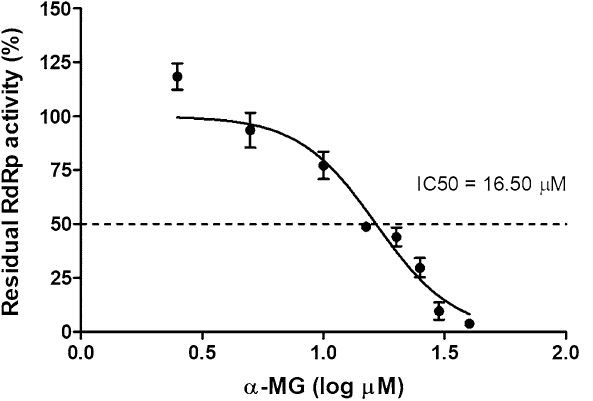
Figure 3. α-MG inhibits the activity of DENV-2 RdRp. The inhibitory effect of α-MG on the activity of DENV-2 RdRp was performed by in vitro fluorescence-based transcription assay. Dose–response curve shows inhibition by α-MG (0–40 μM) against the activity of DENV-2 RdRp at 2 μM. The positive and negative controls were treated with EtOH in the presence and absence of poly(C) templates, respectively. IC50 values were obtained by non-linear regression analysis using GraphPad Prism. The results show the mean ± SD values from three independent